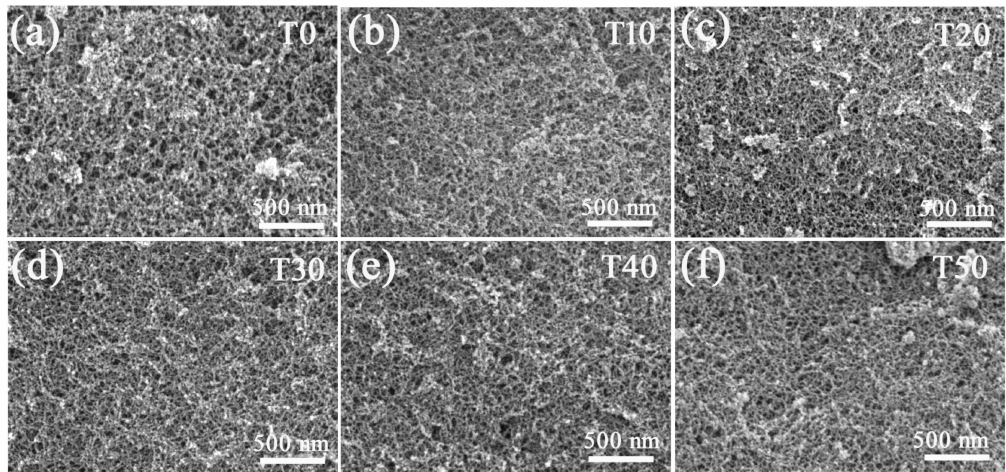
Figure 2. SEM images of the aerogel samples; ( a ) T0, ( b ) T10, ( c ) T20, ( d ) T30, ( e ) T40, and ( f ) T50.